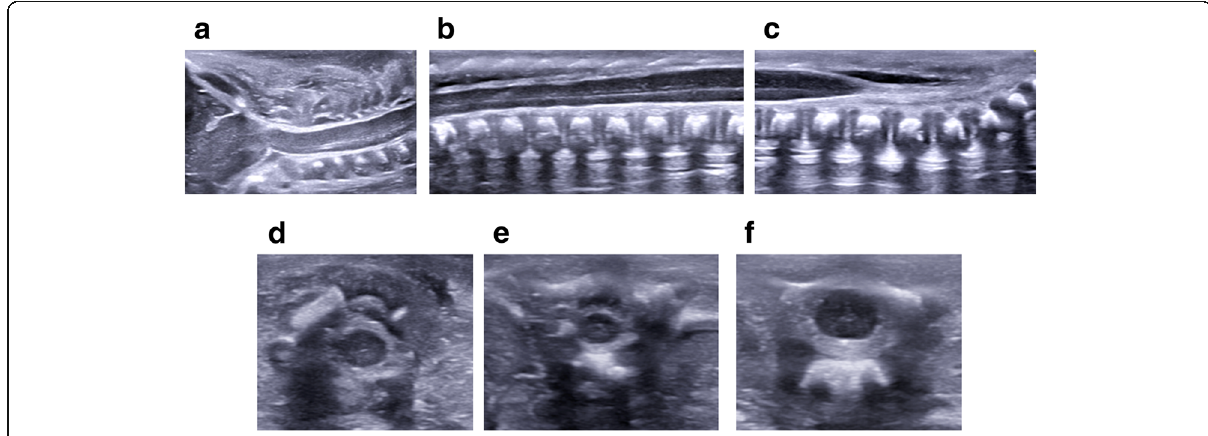
Fig. 6 Sagittal postmortem ultrasound images of a normal cervical spine ( a ), thoracolumbar spine ( b ) and lumbosacral spine ( c ) in a 21-week gestational-aged foetus, obtained 12 days after death. Corresponding transverse views of the cervical ( d ), thoracic ( e ) and lumbar ( f ) spinal cord are also shown from a routine normal postmortem ultrasound examination